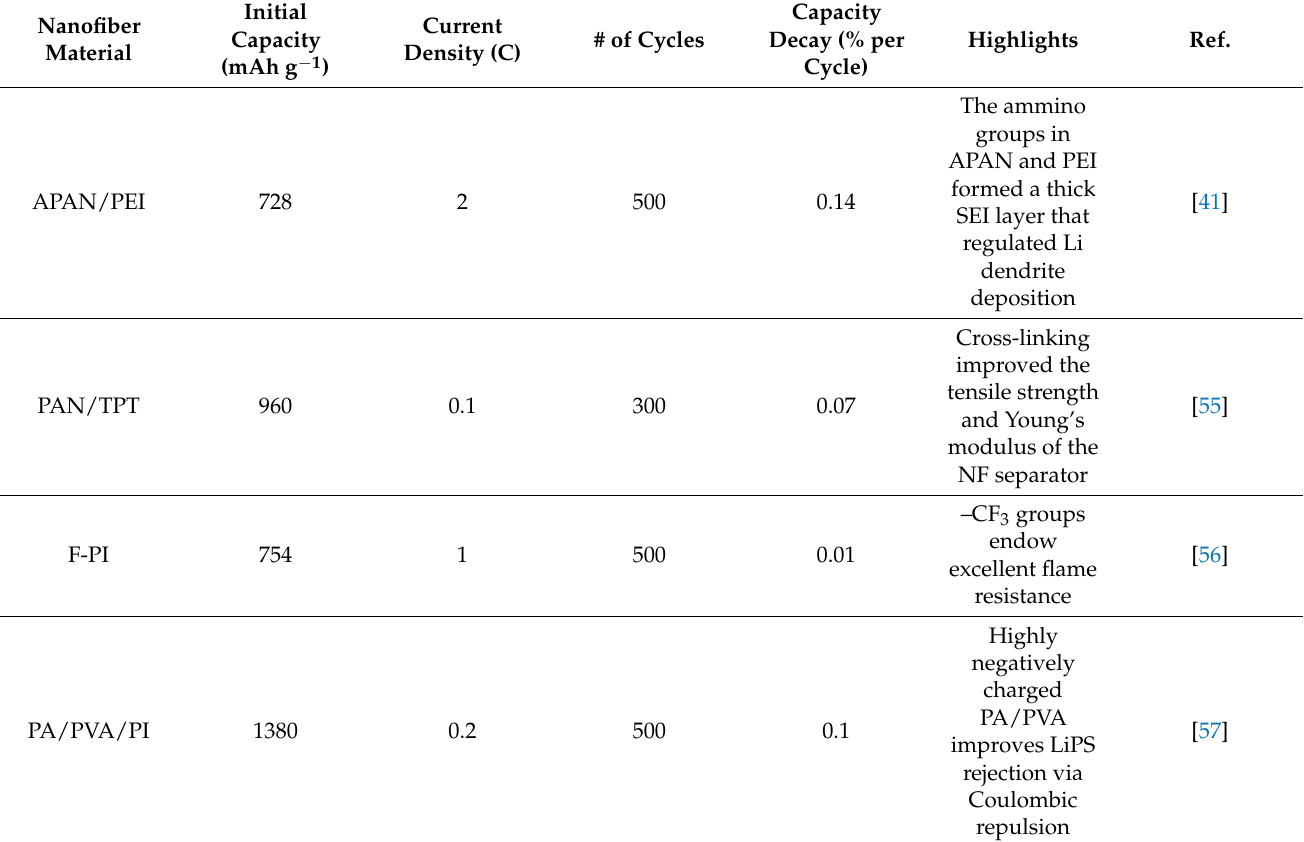
The performance and notable developments LSBs with novel polymer-based and CNF